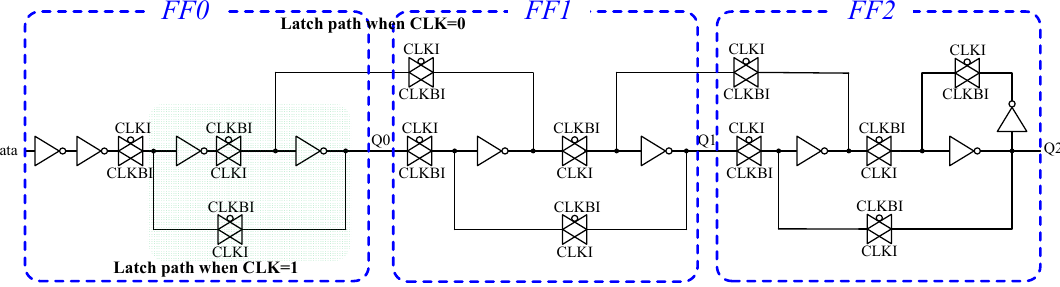
Figure 5. Schematic of the proposed CLSR architecture. Figure 4. Shift register architectures: ( a ) master–slave design and ( b ) the proposed cross-latch shift register (CLSR) design.